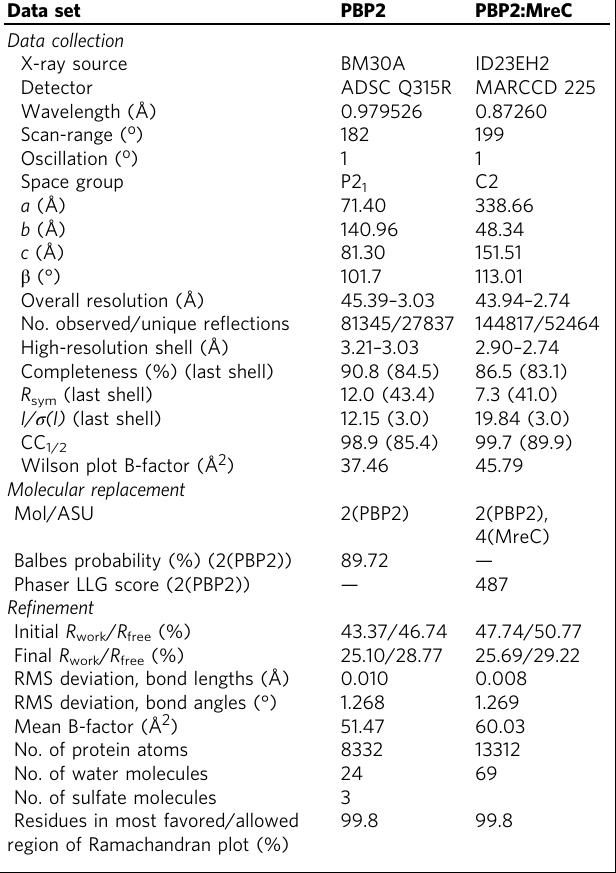
Table 2 Data collection, molecular replacement, and structure re fi nement